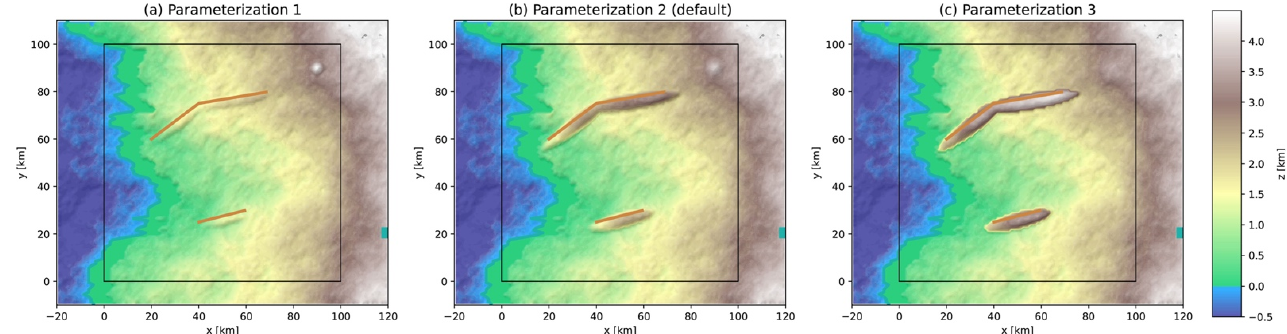
Figure 4. Generation of a volcano and of hills due to active thrust faulting. Tectonic hills are modeled by an ellipsoid extruding the background topography and the volcano is modeled as an extruding cone. ( a ) Parameterization 1: ∆ z hill = − 1.5, h volc = 2 km and w volc = 6 km; ( b ) Parameterization 2 (digital template’s default parameterization): ∆ z hill = − 0.5, h volc = 1 km and w volc = 9 km; ( c ) Parameterization 3: ∆ z hill = + 0.5 km, h volc = 0.5 km and w volc = 15 km. The volcano symbol is hidden to clearly show the modeled volcano. The parameter values were changed to illustrate the process of topography extrusion, and do not necessarily represent realistic estimates of real